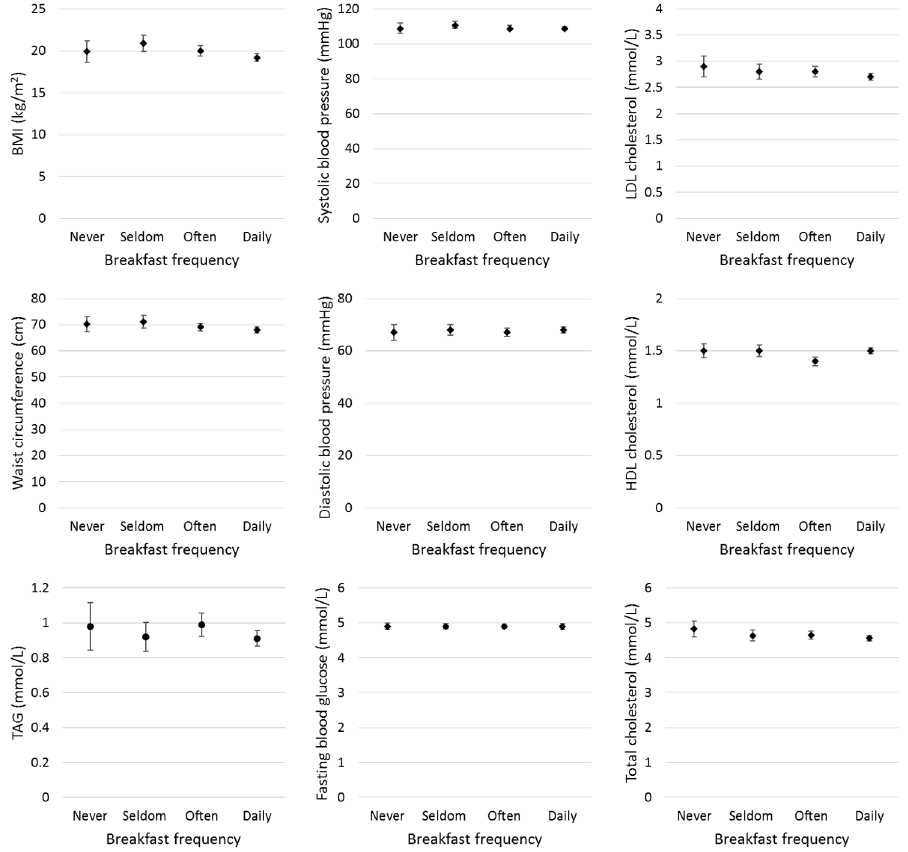
Figure 4. Baseline associations between breakfast frequency and cardiovascular disease (CVD) risk factors in MyHeARTs. Never = 0 days a week, n = 76; Seldom = 1–3 days a week, n = 115; Often = 4–6 days a week, n = 196; Daily = 7 days a week, n = 408. Abbreviations—BMI: body LDL: low-density lipoprotein; TAG: triacylglycerol.